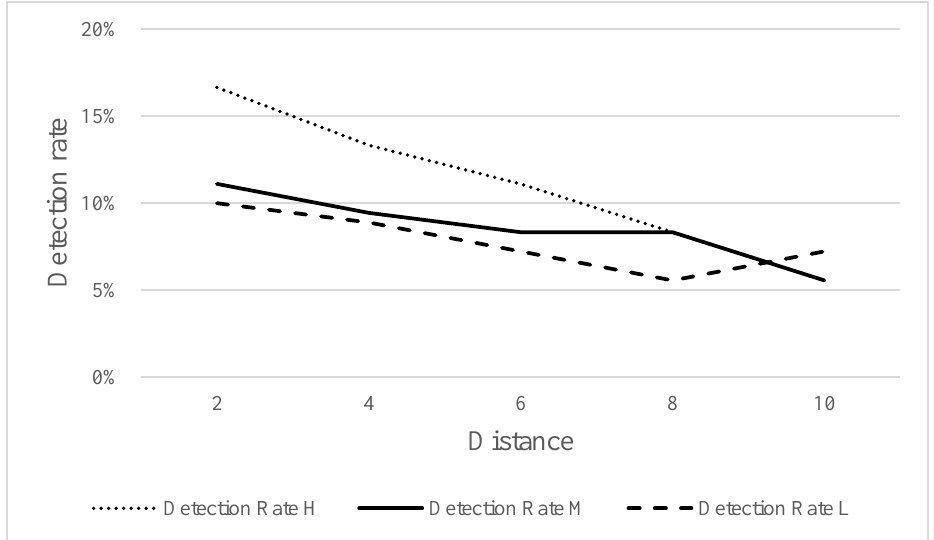
Figure 9. Detection rates for three frequencies of warning sounds at different distances.